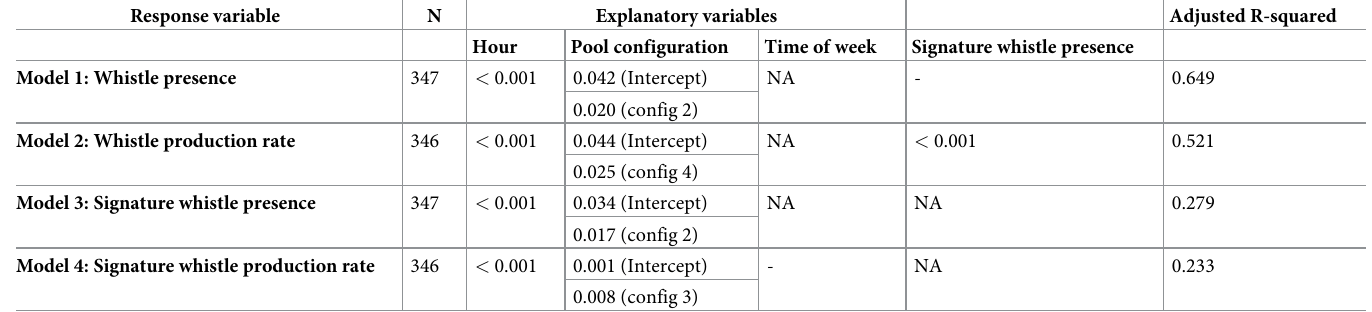
Table 3. GAMM results for four models (only p- values < 0.05 are presented).